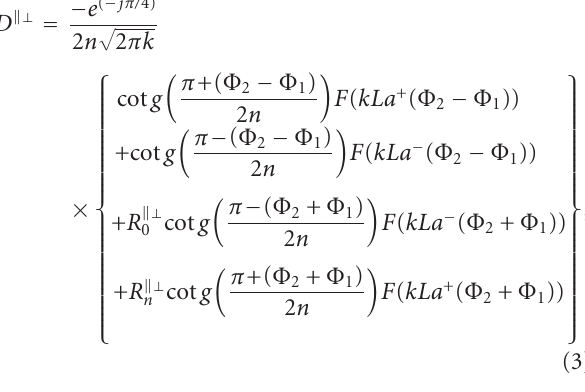
Figure 8: Bidimensional distribution of received power (dBm) for a height plane of 1.05 m in the indoor scenario of Figure 2(a) calculated with the 3D ray launching algorithm.